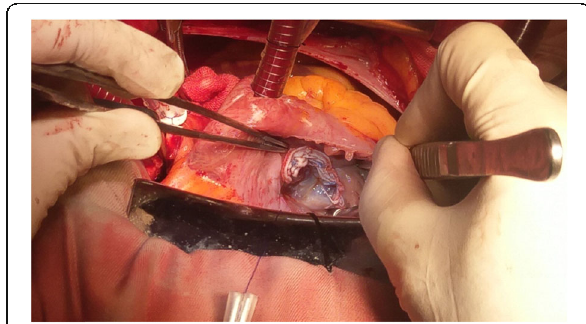
Fig. 1 tricuspid fashioned Dacron band after saline test